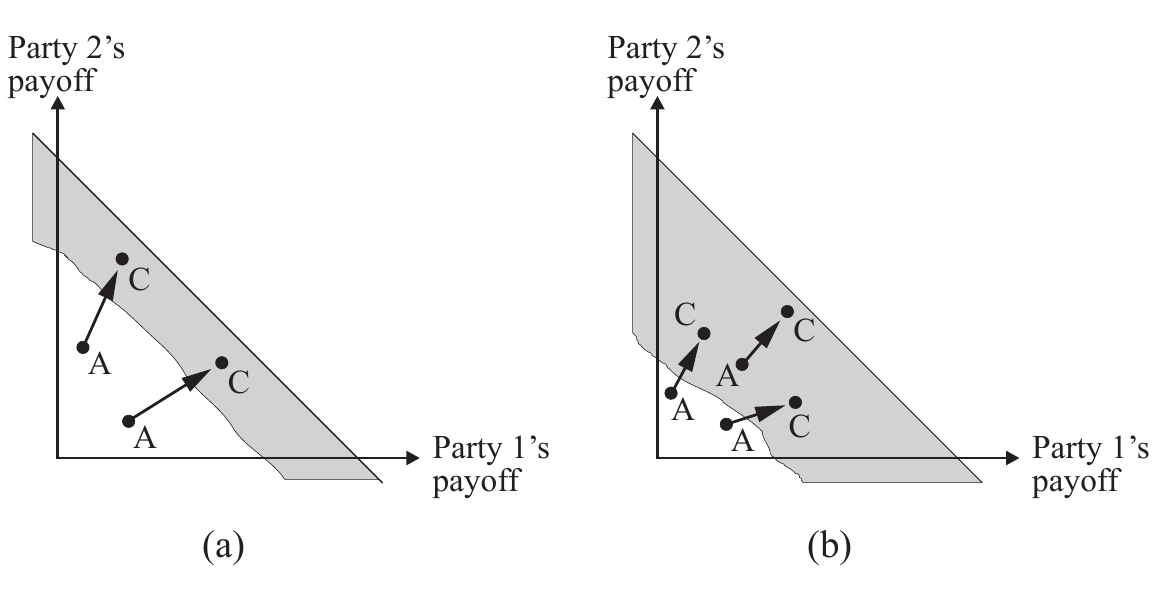
Figure 2. Illustration of the monotonicity